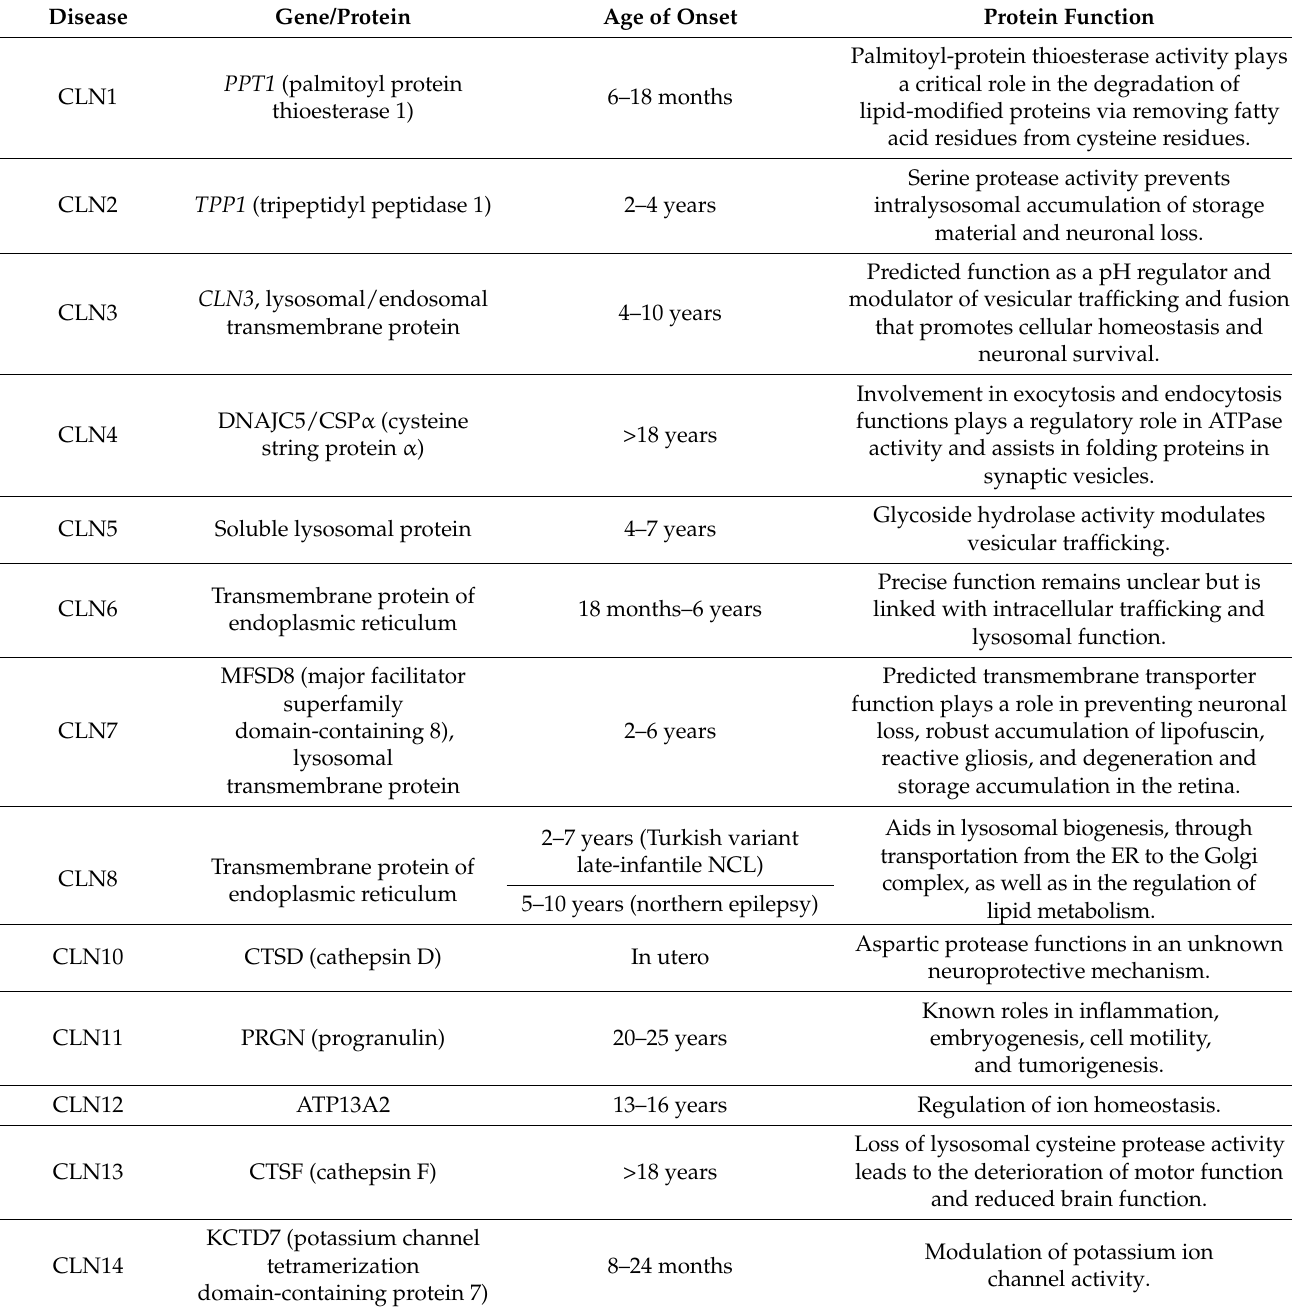
Table 2. NCL diseases and encoded genes